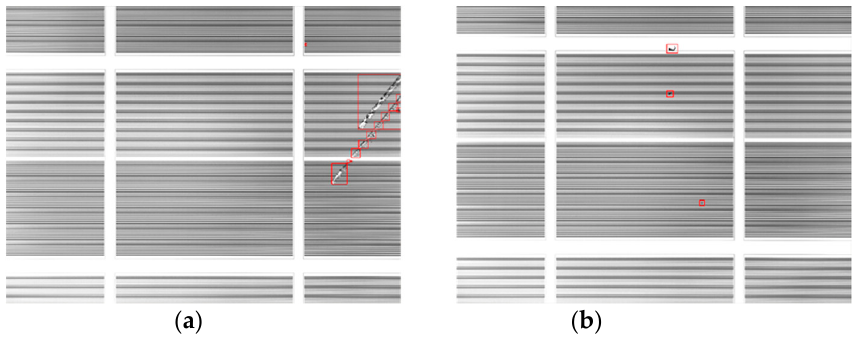
Figure 18. ( a ) Scratches and ( b ) stains were identified and marked by the proposed algorithm.